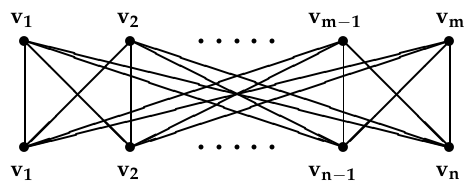
Figure 4. Complete bipartite graph K m , n .